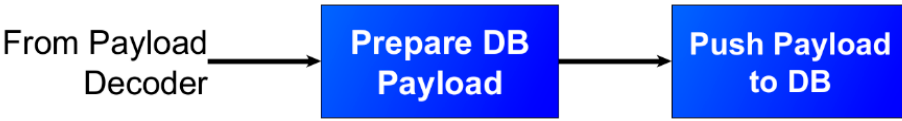
Figure A6. Data storage preparation and storage operation flow for device data integration.